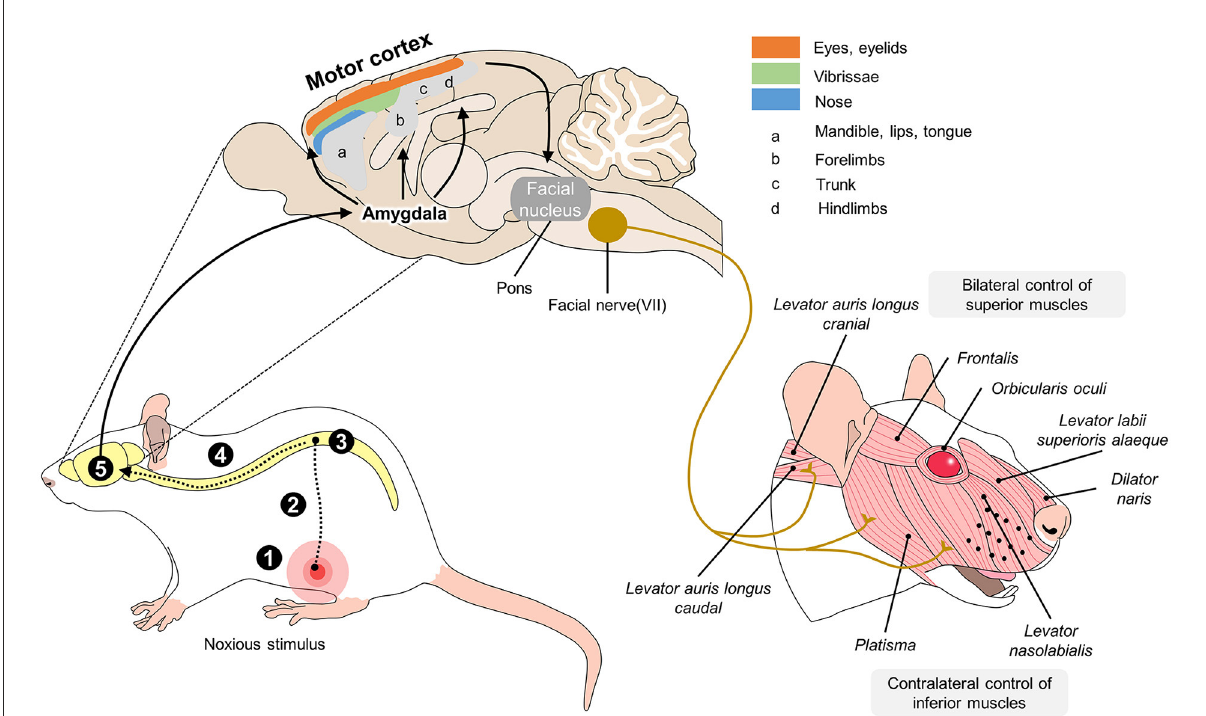
FIGURE2 Neurobiology of facial expressions in R. norvegicus. The production of facial expressions associated with pain begins with the nociceptive pathway. When the nociceptive signal reaches the brain, the thalamus projects connections to the amygdala, the main center that initiates facial motor responses. From the amygdala, the motor cortex is activated in various areas responsible for controlling the eyes, vibrissae, nose, jaw, and pelvic and thoracic limbs. Once activated, areas of the motor cortex connect directly to the facial nucleus in the pons and, in turn, with cranial nerve VII, which innervates all the muscles involved in facial expressions. In rodents, the muscles described in the image are responsible for maintaining the position of the ears and whiskers and movements of the eyelids and nose, which are considered rat-specific facial action units (FAUs) for pain recognition. 1. transduction; 2. transmission; 3. modulation; 4. projection; 5.